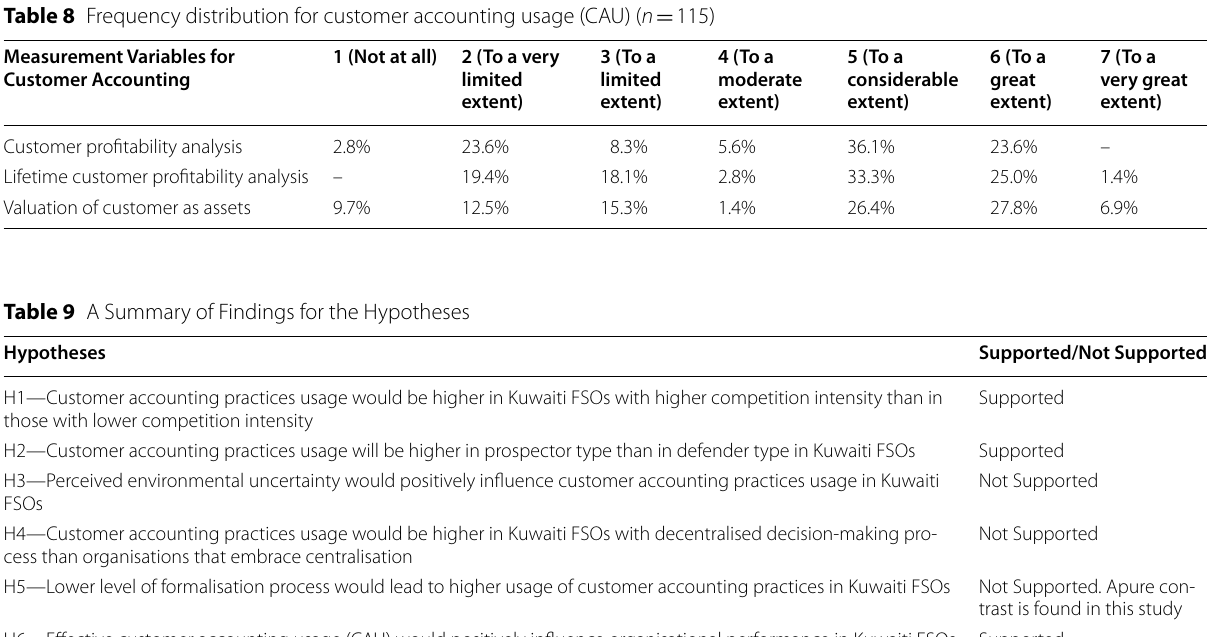
115) = 1 (Not at all) 2 (To a very limited